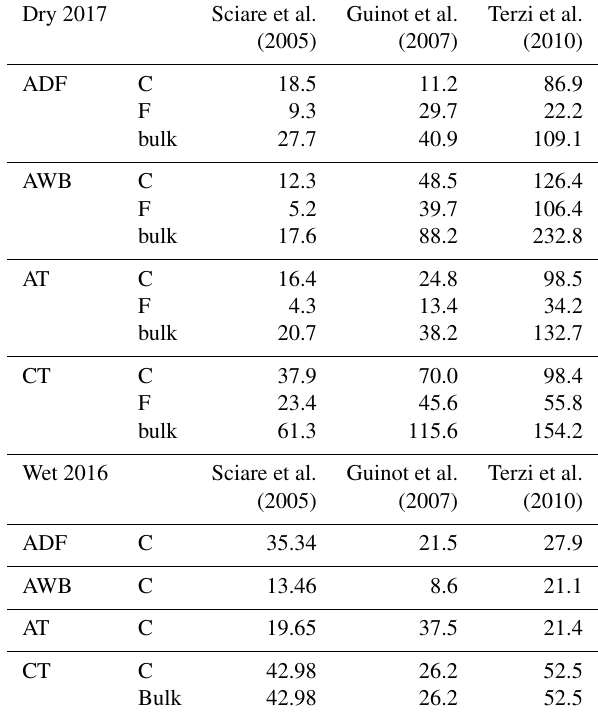
Table 1. Comparison of dust concentrations obtained from different methodologies, in micrograms per cubic